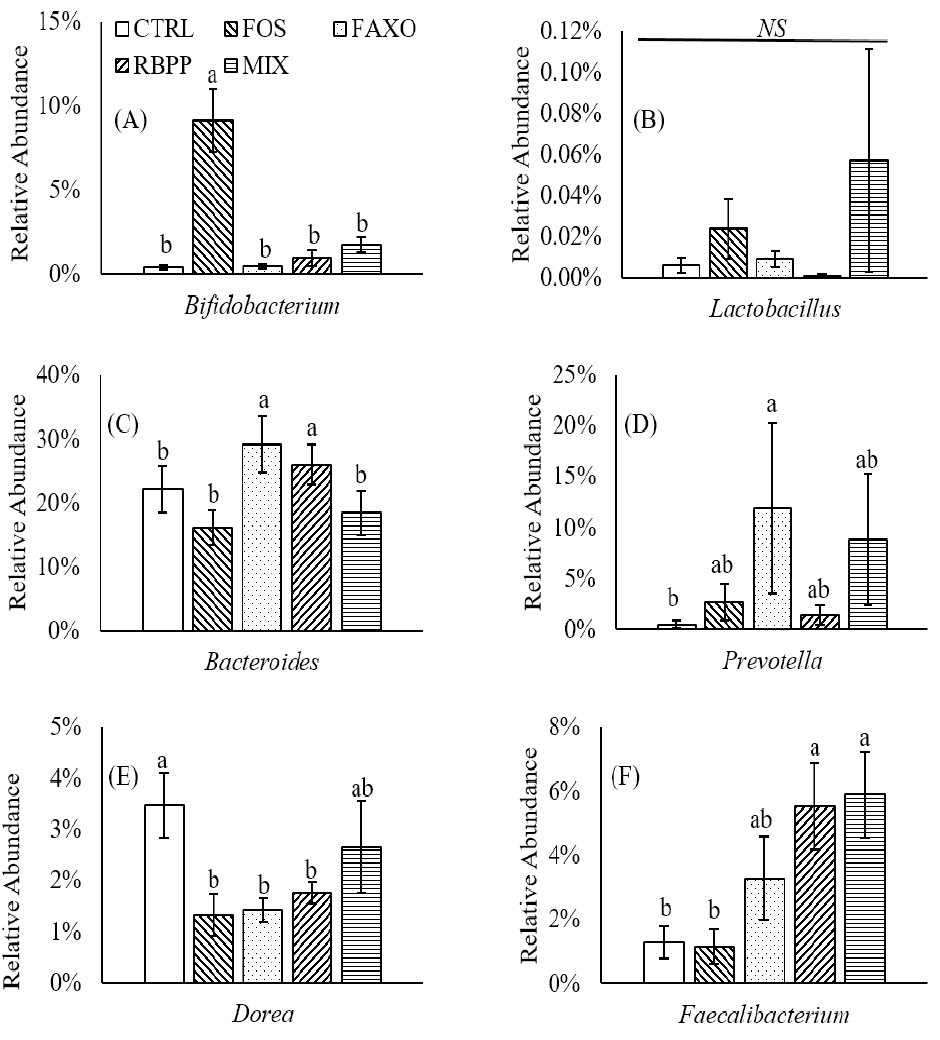
Figure 3. Change in abundance of different genera after 24 h incubation with different substrates. ( A ) Bifidobacterium ; ( B ) Lactobacillus ; ( C ) Bacteroides; ( D ) Prevotella ; ( E ) Dorea ; ( F ) Faecalibacterium . Data are expressed as mean ± SEM. Different letters denote significant difference ( p < 0.05). CTRL: no substrate, FOS: fructooligosaccharides, FAXO: feroloylated arabinoxylan oligosaccharides, RBPP: rice bran polyphenols, MIX: mixture of FAXO and RBPP.